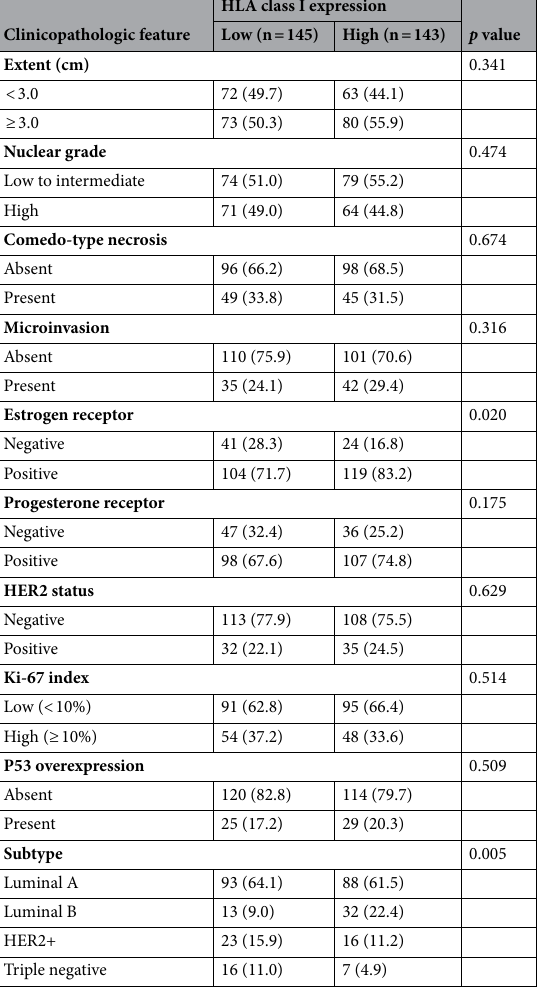
Table 3. Relationship between HLA class I expression level and clinicopathologic features of DCIS. p values are calculated by Chi-square test. HLA human leukocyte antigen, DCIS ductal carcinoma in